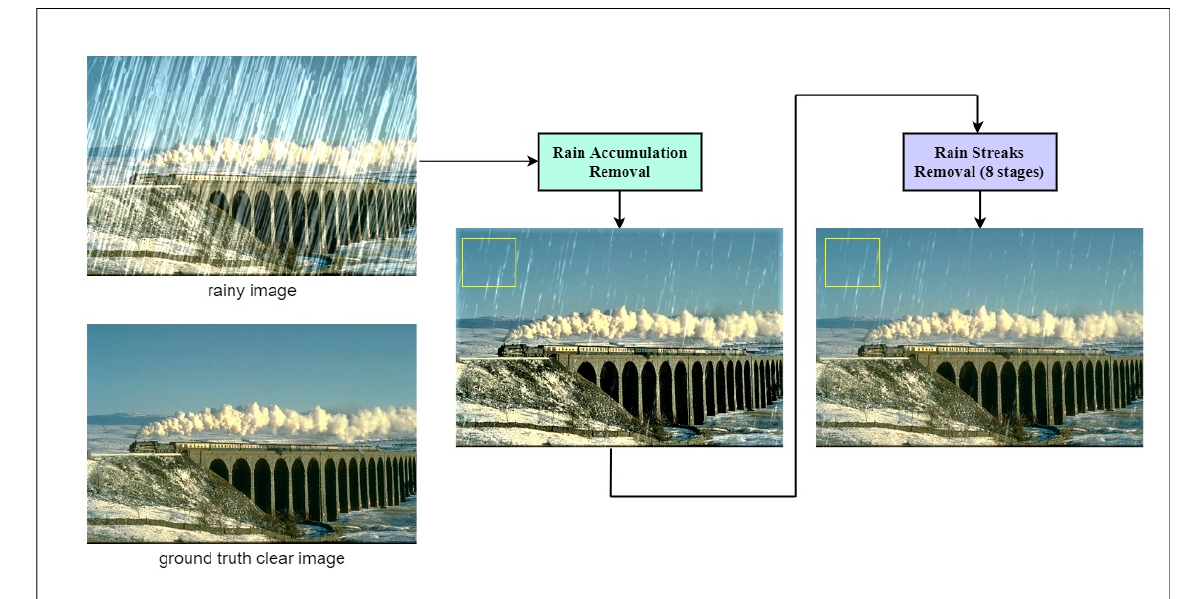
Figure 7. The effect of applying rain accumulation removal as a pre-processing step, and then rain streak removal.